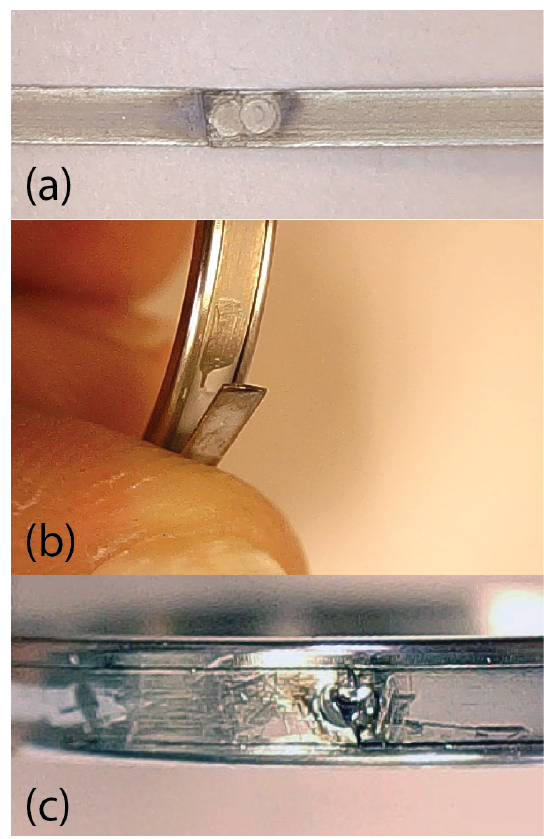
Figure 9. (a) Permalloy strips joined by spot-welding. (b) Permal- loy strip wound onto bobbin ready for final weld (note patch of re- moved magnesia coating). (c) Permalloy strip spot-welded to itself to finish the spiral